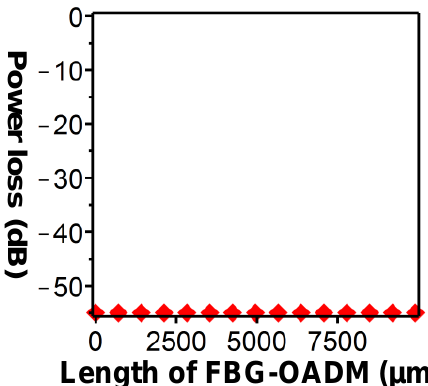
Figure 12. Diagram of the relationship between the transmission distance and power loss when the core mode was completely dropped.